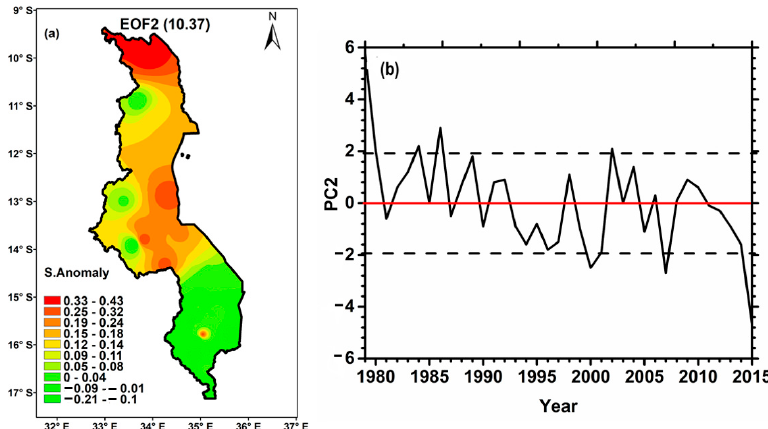
Figure 5. EOF 2 of the wet season precipitation. ( a ) Spatial variability and ( b ) its corresponding PC over Malawi based on data from 31 rainfall stations during 1979–2015.